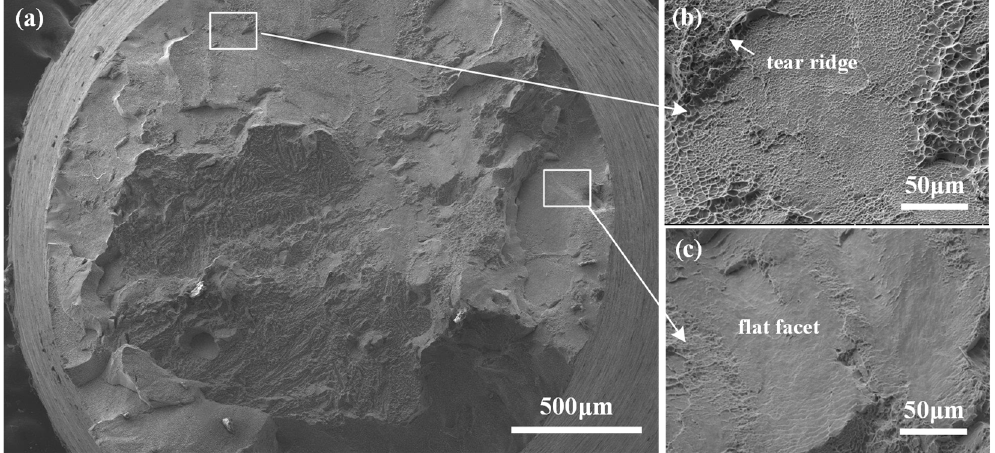
Figure 6. Fracture morphology after SSRT of the AM2 alloy tested in 3.5% NaCl aqueous solution: ( a ) macro morphology; ( b ) the image of tear ridges; ( c ) the image of flat facets.